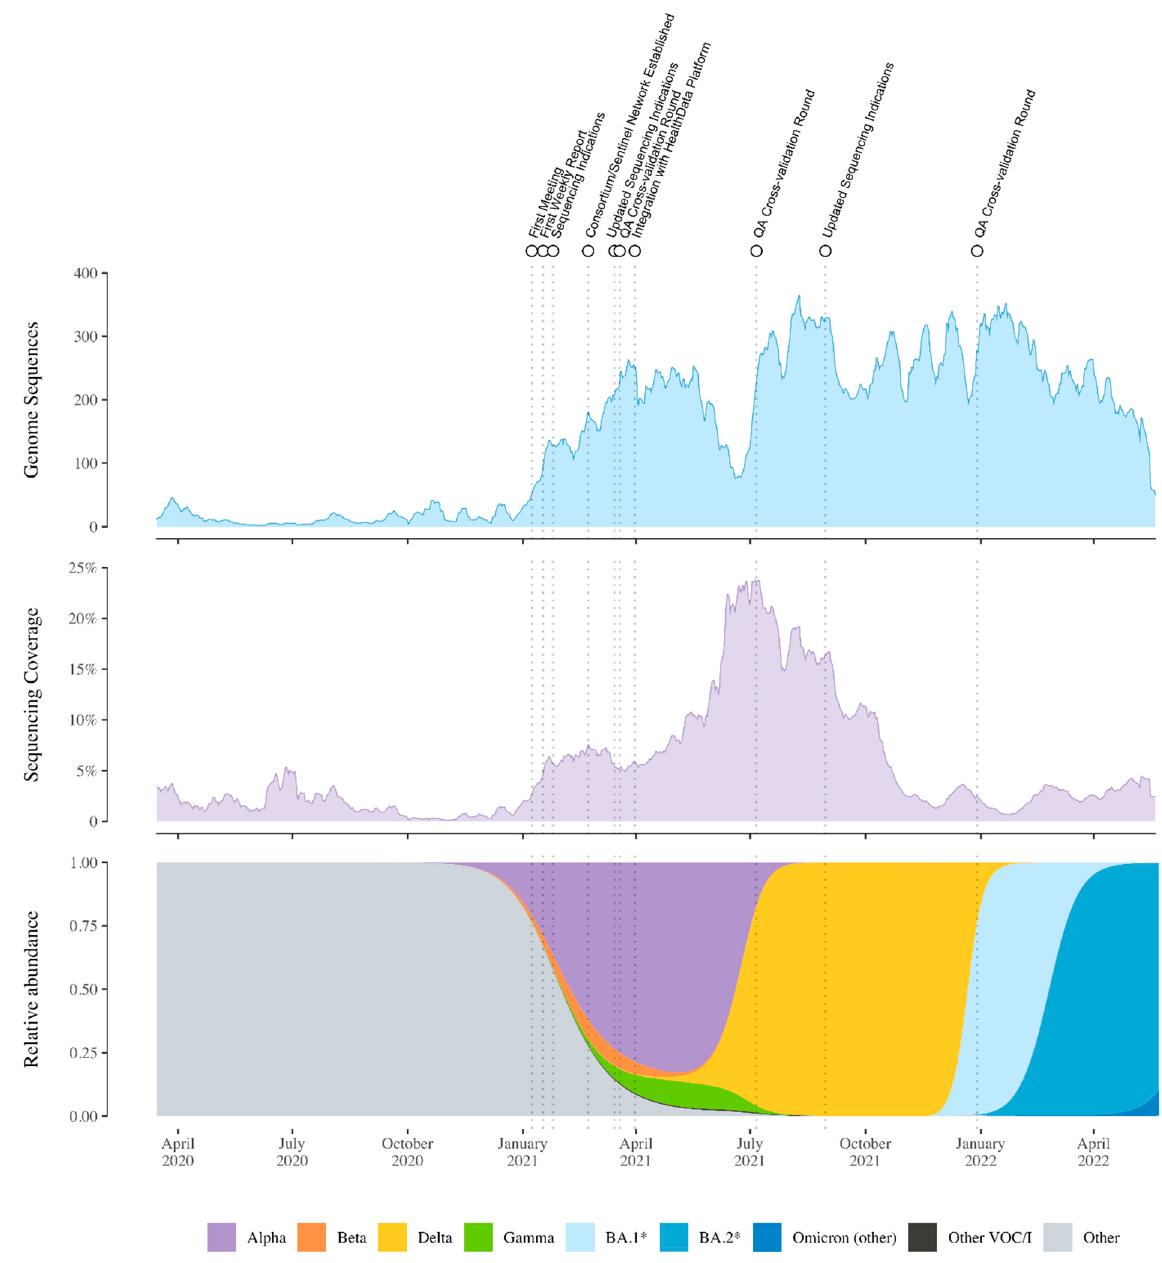
Figure 5. Sequencing numbers, sequencing coverage (the ratio between genomes sequenced and confirmed cases), and relative abundance of SARS-CoV-2 variants of concern in Belgium. Individual colors were assigned to lineages depending on their VOC status and prevalence in Belgium. Dotted lines indicate events related to the COVID-19 Belgium Genomics Consortium.